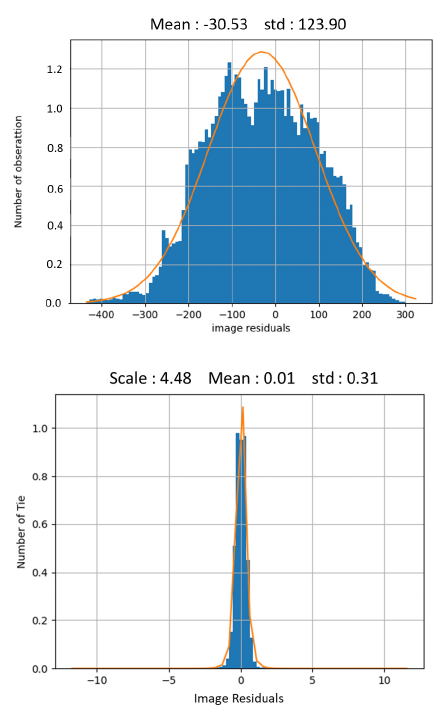
Figure 7. (up) image residuals before SBA. (down) image residuals after